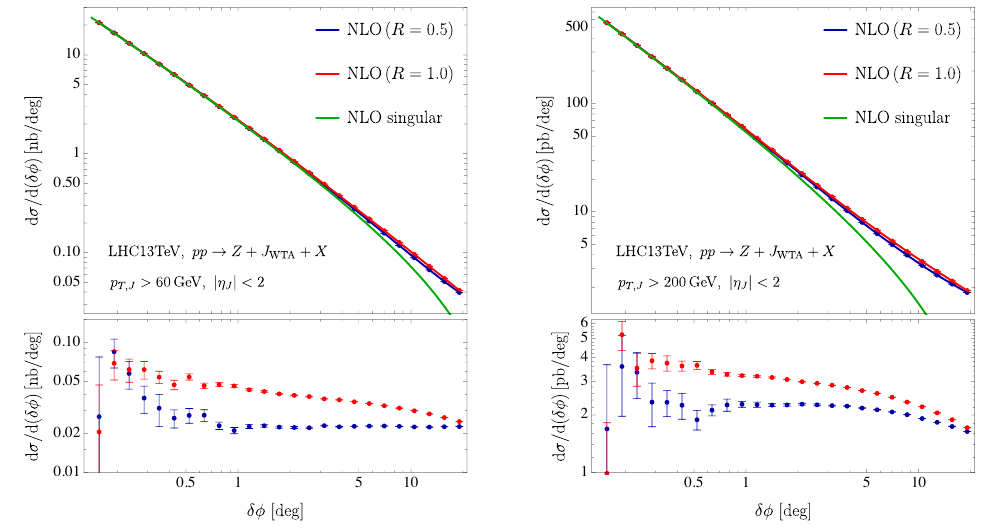
Figure 12. The δφ differential distributions at NLO order for jet transverse momentum p T,J > 60 GeV (left) and p T,J > 200 GeV (right) with jet radius R = 0 . 5 (blue), 1 . 0 (red) and the R - independent singular terms (green). The non-singular cross section (difference of the NLO and NLO singular) is shown in the lower